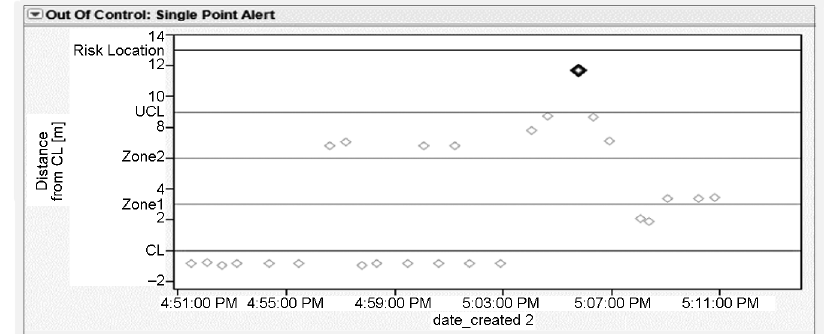
Fig. 2. A deterministic alert of a penetration into the high hazard area beyond the UCL